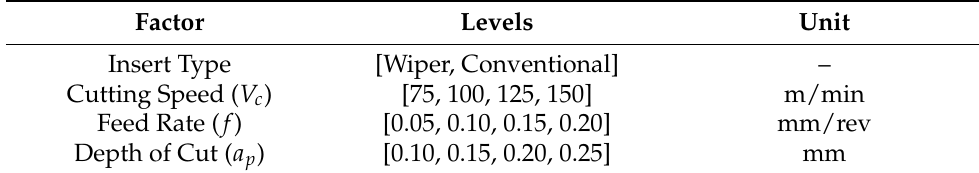
Table 3. The investigated parameters and their